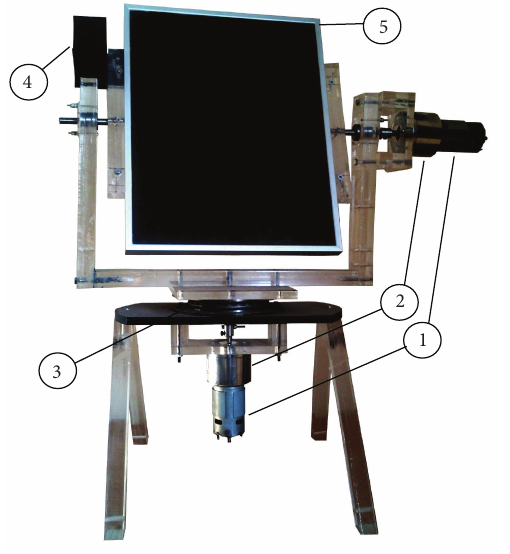
Figure 4: Electromechanical structure (motors (1), gearboxes (2), thrust bearing (3), imaging device (4), and solar panel